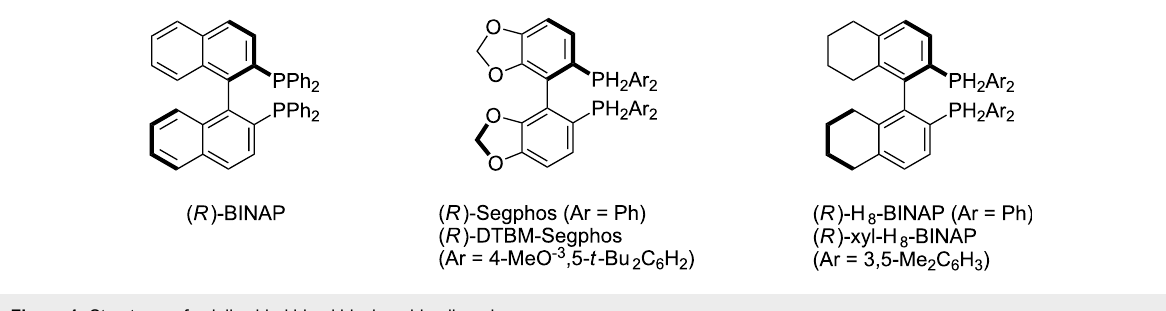
Figure 1: Structures of axially chiral biaryl bisphosphine ligands.